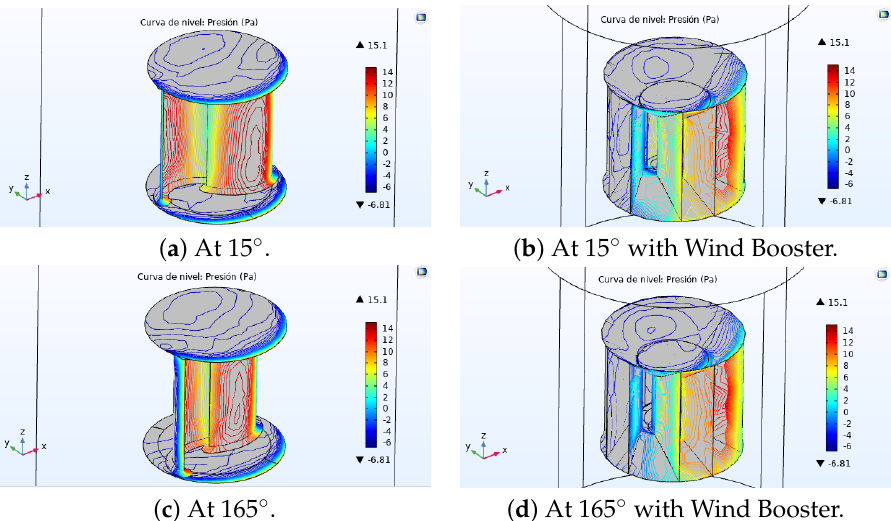
Figure 16. Amount of pressure that wind produces on blades. Savonius alone ( a , b ), and with Wind Booster ( c , d